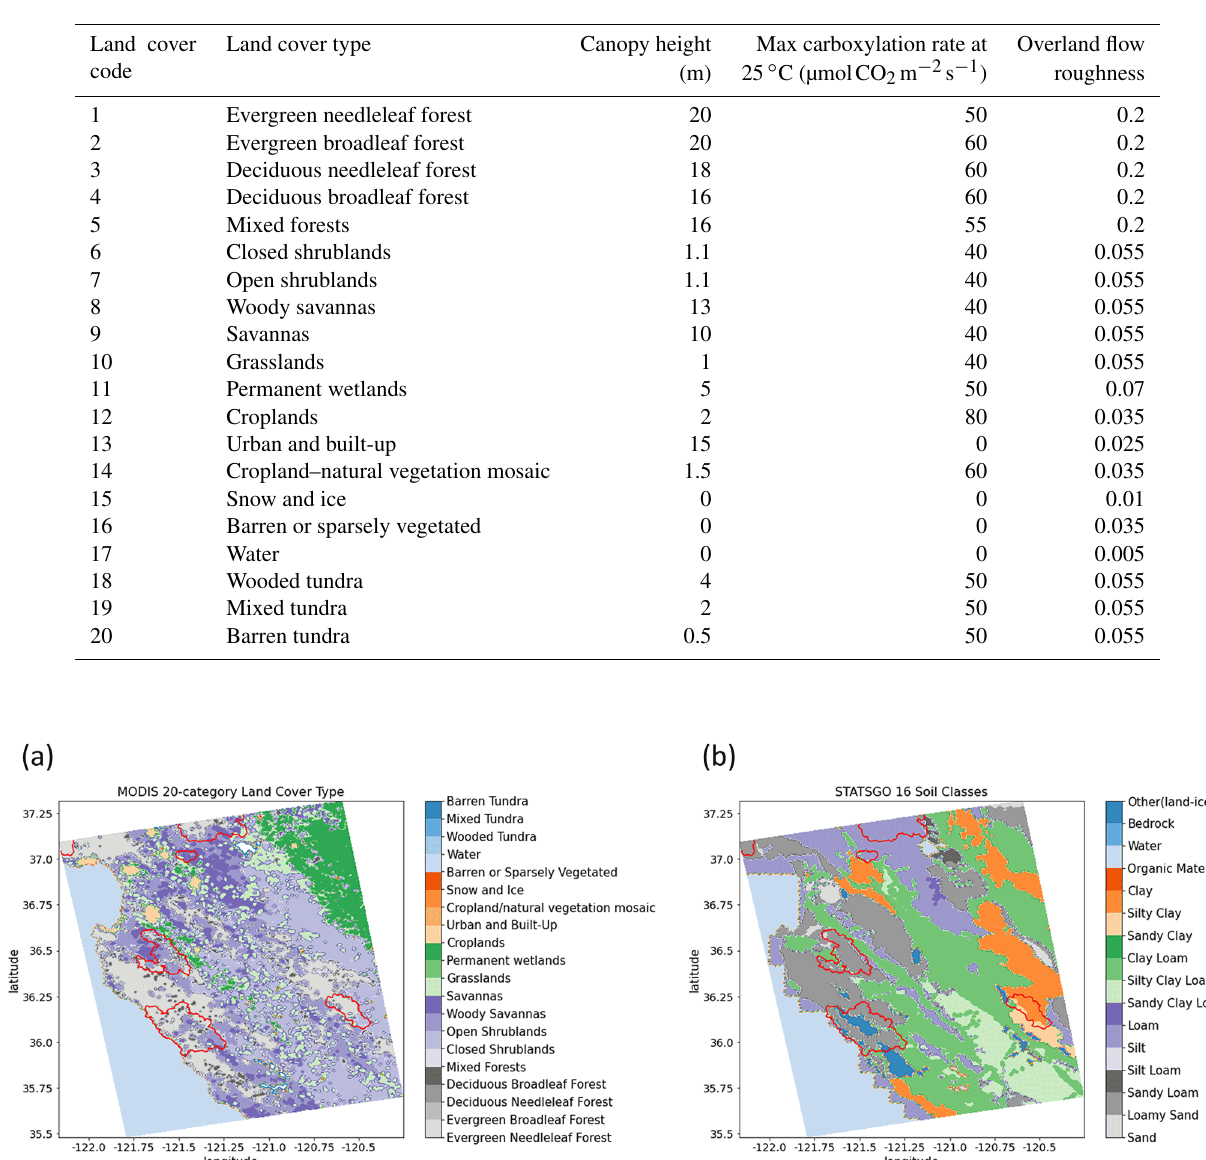
Table B2. MODIS IGBP 20-category land cover type and properties in Noah-MP LSM.